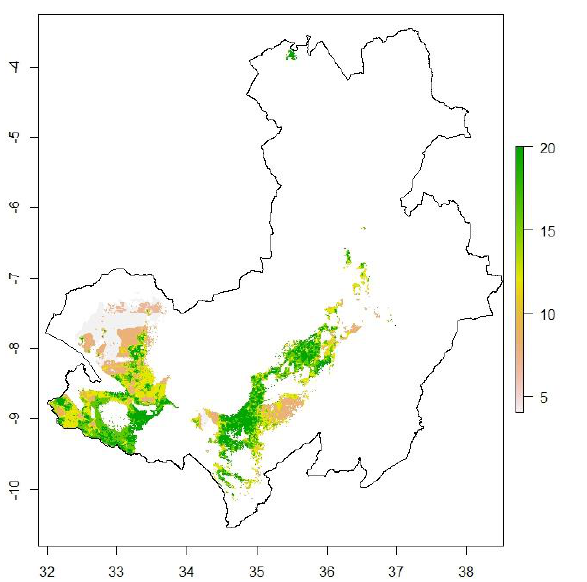
Figure 5. The Impact Based Spatial Targeting index (IBSTI) values for zone with ESI = 4. Higher IBSTI value indicates more potential impact for scaling candidate technology. Technology scaling interventions should prioritize zone with IBSTI = 20 to maximize potential impact.